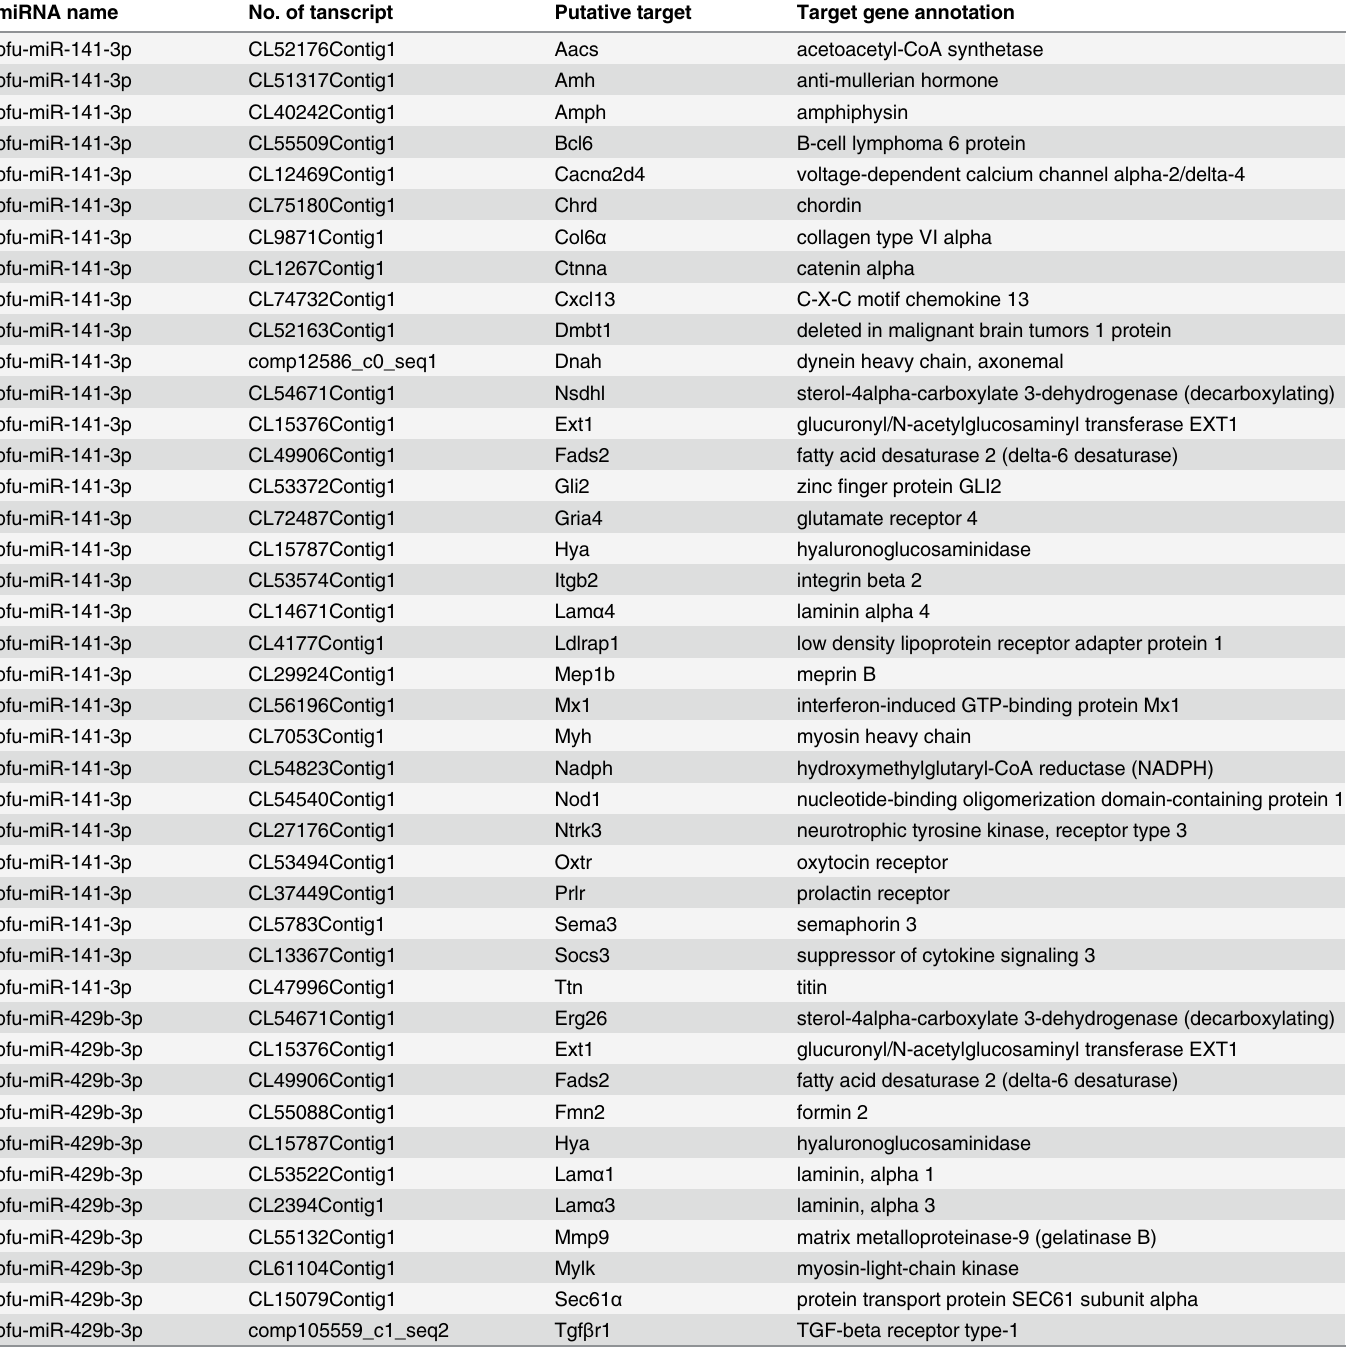
Table 1. The predicted targets of miR141/429 that displayed higher expression in YY than